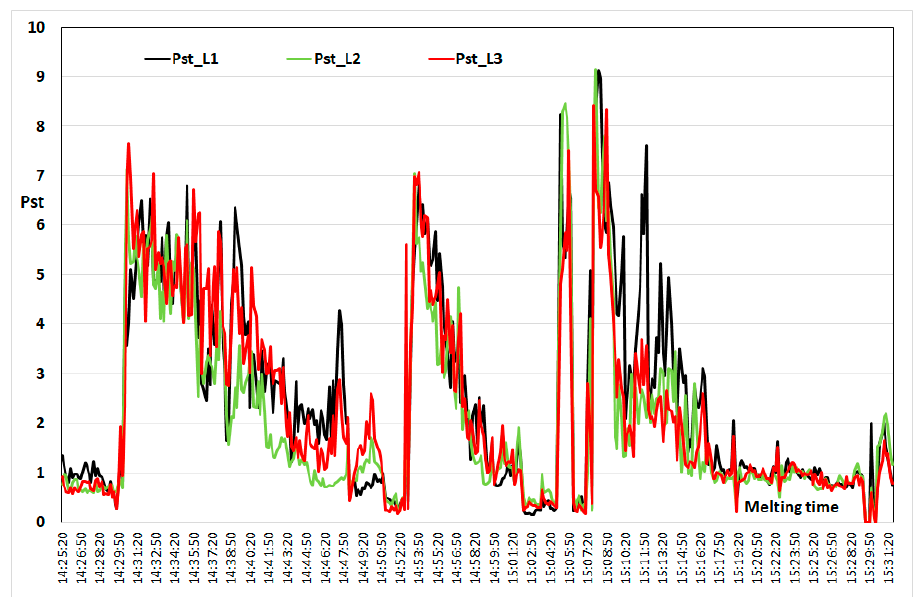
Figure 4. Short-term light flicker changes P st index recorded in phases L 1 , L 2 and L 3.